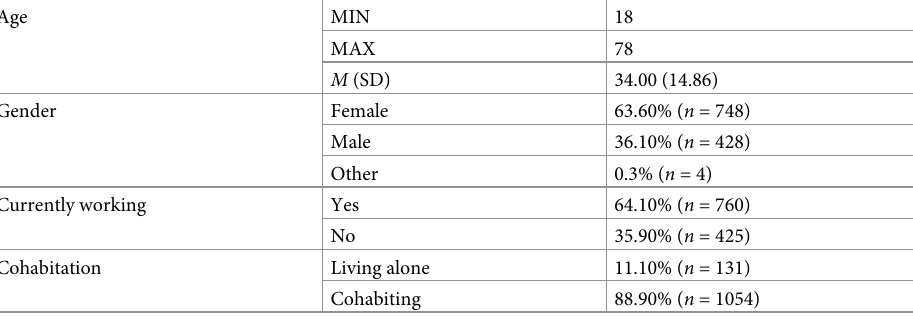
Table 2. Descriptive statistics for demographic